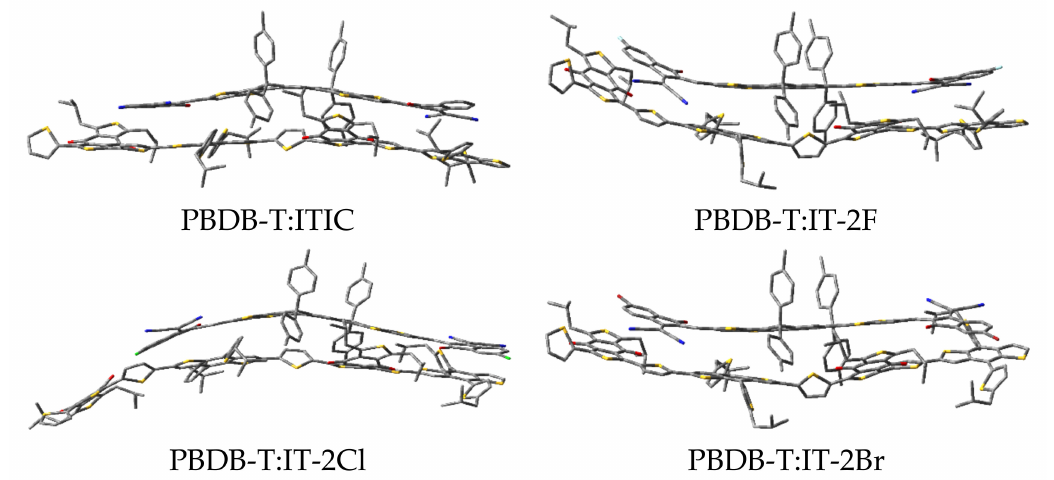
Figure 5. The optimized structures of PBDB-T:ITIC and PBDB-T:IT-2X (X = F, Cl, Br) complexes. ( ω B97XD/6-31G**). Table 5. The HOMO and LUMO energies (in eV), HOMO − LUMO Gaps (H − L gap , in eV), and binding energies E b (in eV) of the complexes formed by donor and acceptor.